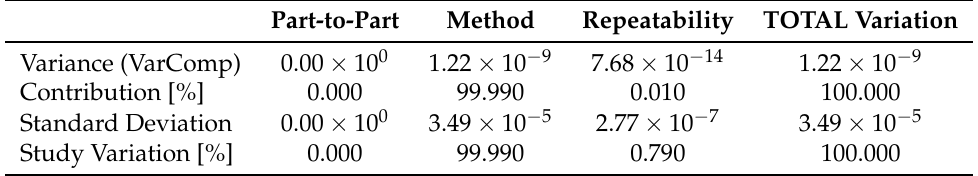
Table 10. Gage R&R significance result for Jcc with optimization.